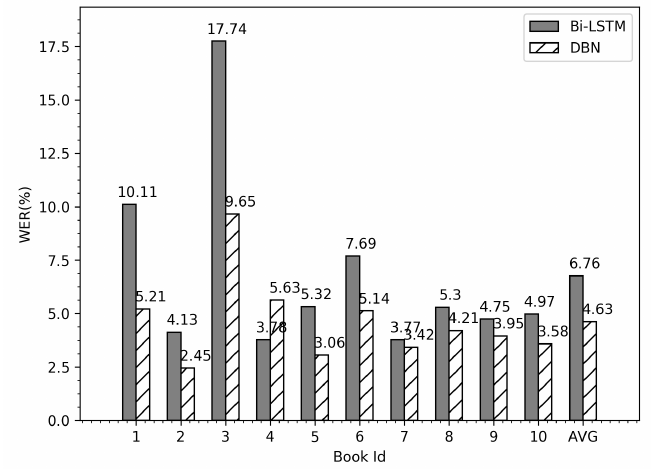
Figure 10. WER results using DBN vs. Bi-LSTM on the Tashkeela